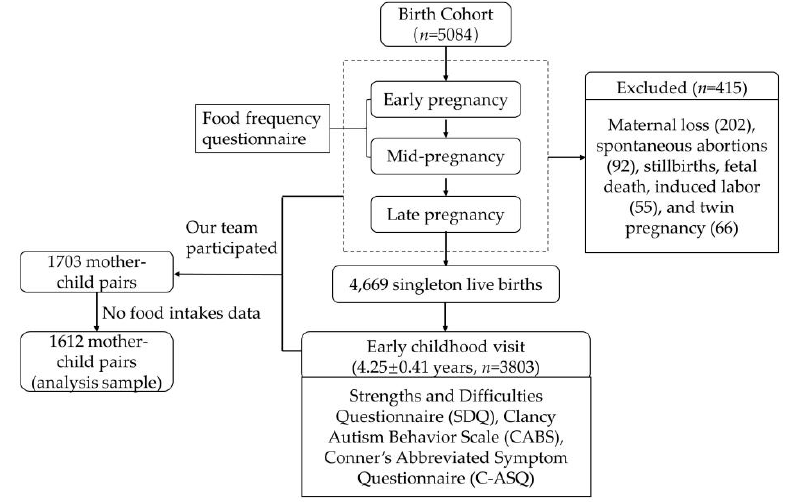
Figure 1. Flow-diagram of the cohort participants.